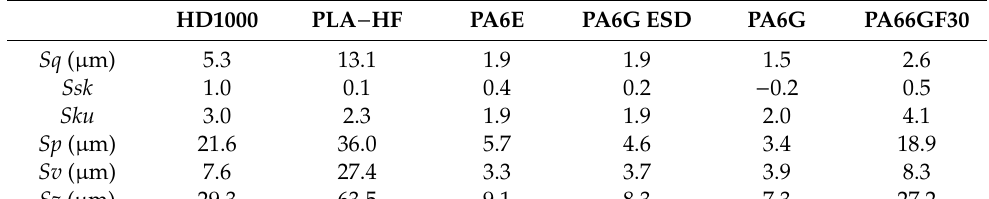
Table 7. Original surface characteristics of the tested polymers.